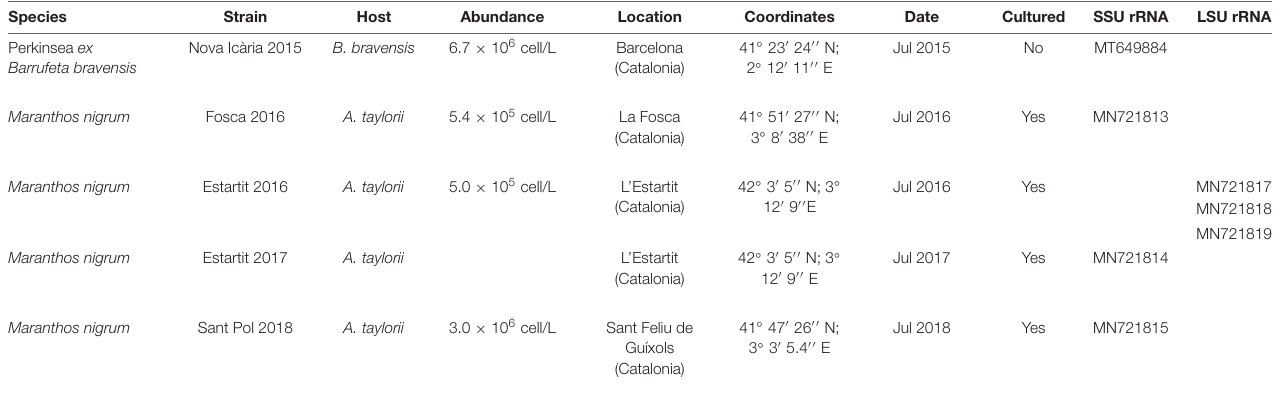
TABLE 1 | Information on the detections of parasitoids and molecular sequences obtained.